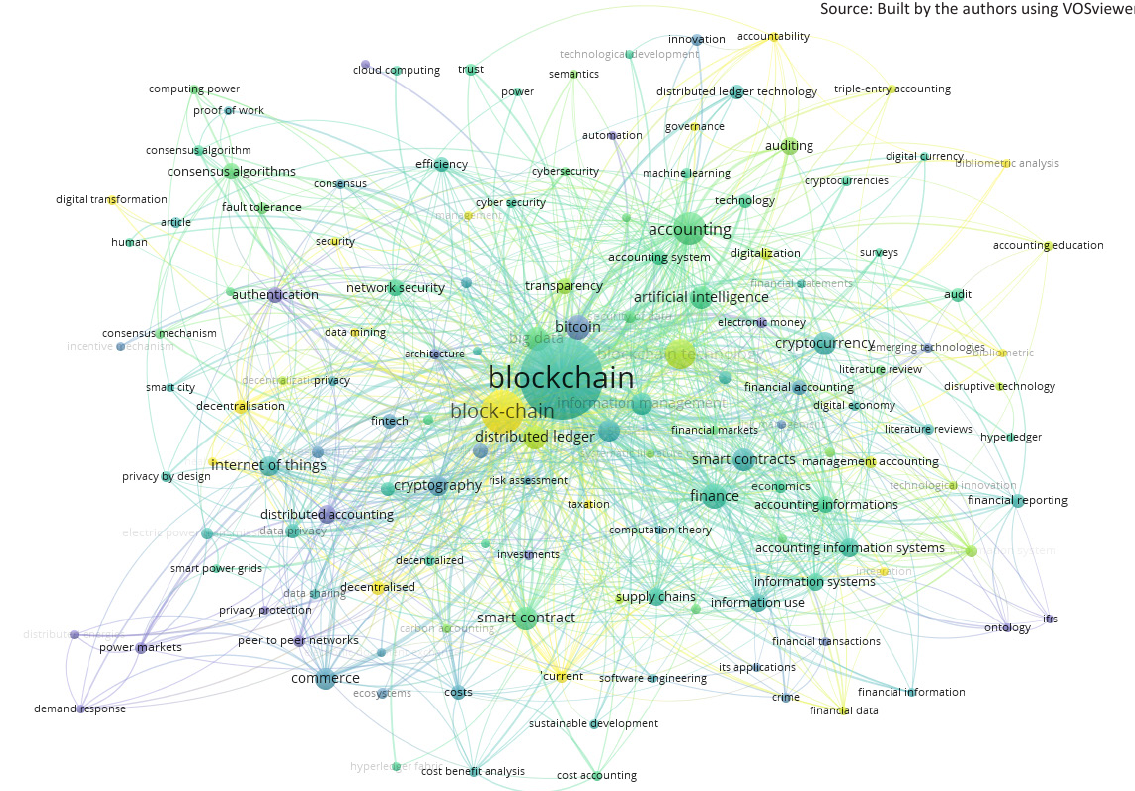
Figure 6. Visualization map of the contextual-temporal dimension of research on “blockchain” AND “accounting”, published in the editions of